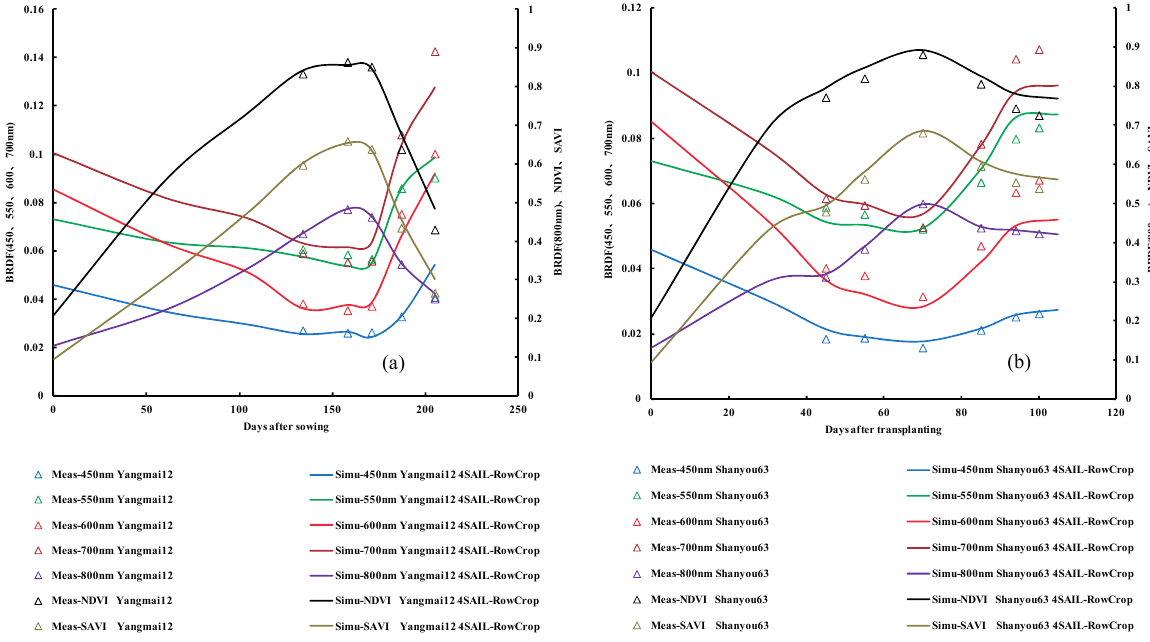
Figure 8. Measured versus simulated canopy multispectral reflectance during different growth stages of wheat cultivars Yangmai 12 ( a ) and Shanyou 63 ( b ). Days after sowing (Yangmai 12) or days after transplanting (Shanyou 63) refer to different growth stages.